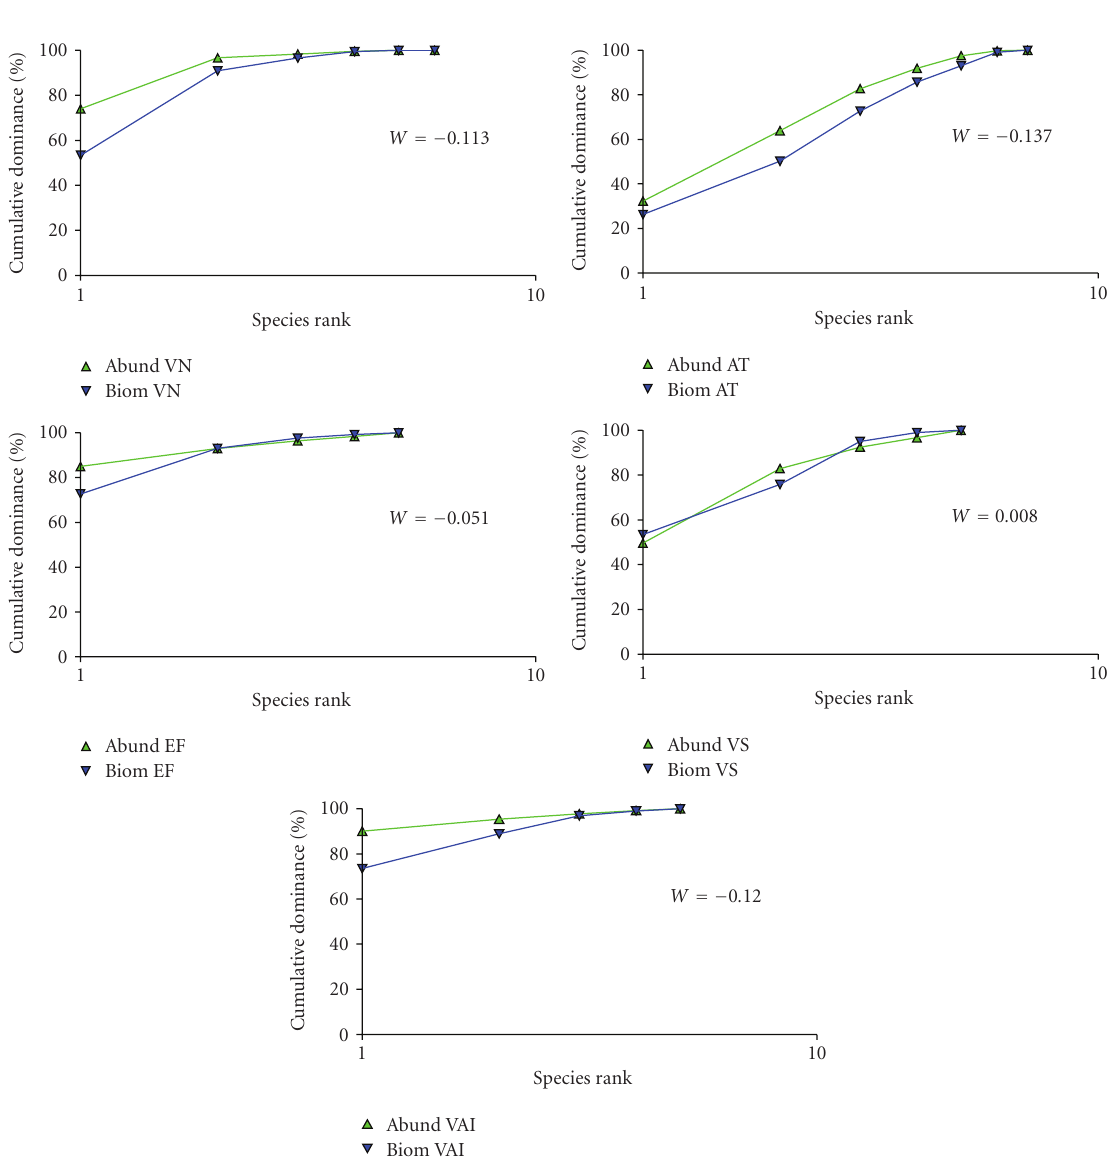
Figure 4: Abundance biomass curves for macroinvertebrate communities in 2000. abund: Abundance; biom: Biomass; VN: Vau; AT: Atalaia; EF: Esteiro-Furado; VS: Vasa-Sacos; VAI: